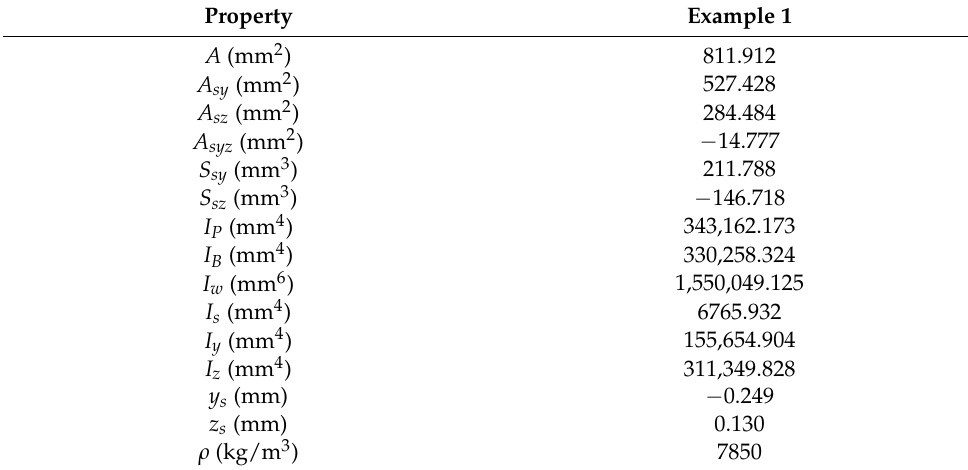
Table 2. Property details of the example 1.